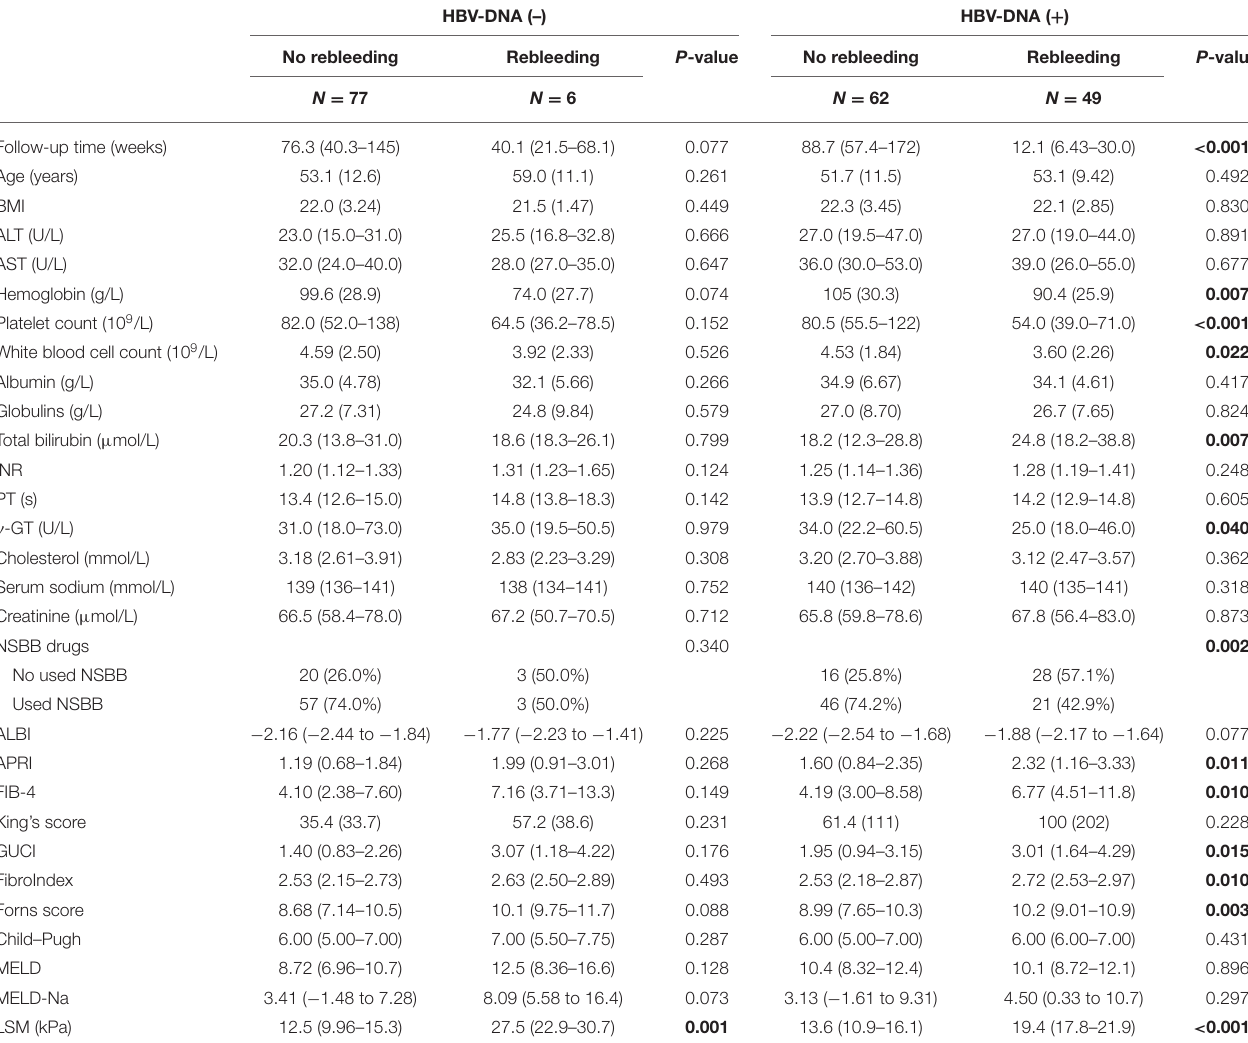
TABLE 4 | Baseline comparison of patients with and without HBV-DNA positivity.